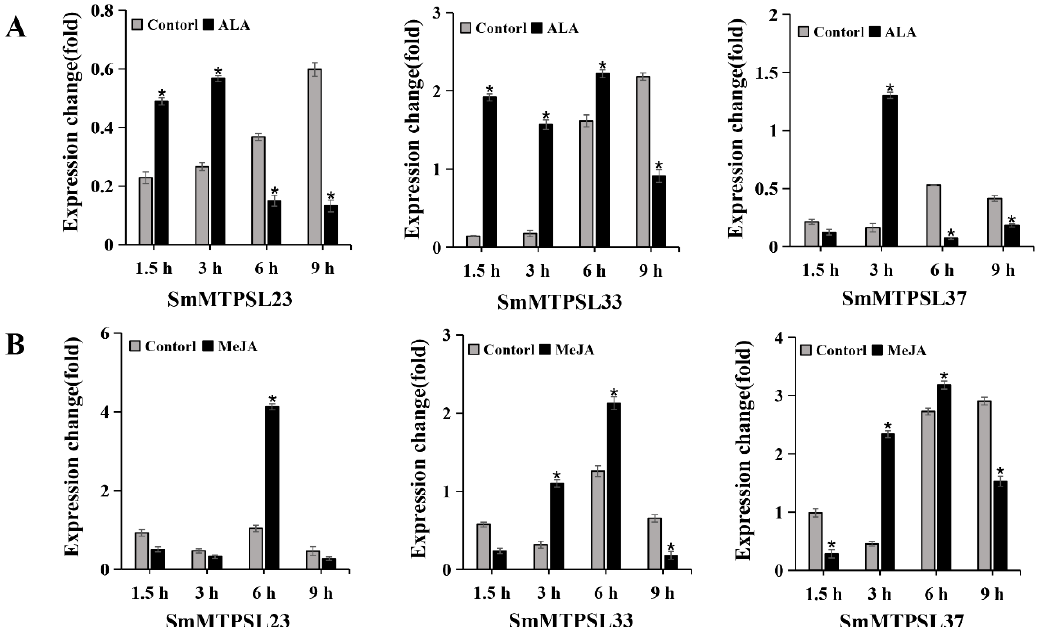
Figure 6. Gene expression of three SmMTPSLs in the leaves of S. moellendorffii treated by ALA ( A ) and MeJA ( B ) treatments. The expression level of S. moellendorffii GAPDH gene was used to normalize the expression of SmMTSLs. * indicates significance at the statistical level ( p < 0.05) compared to the control.